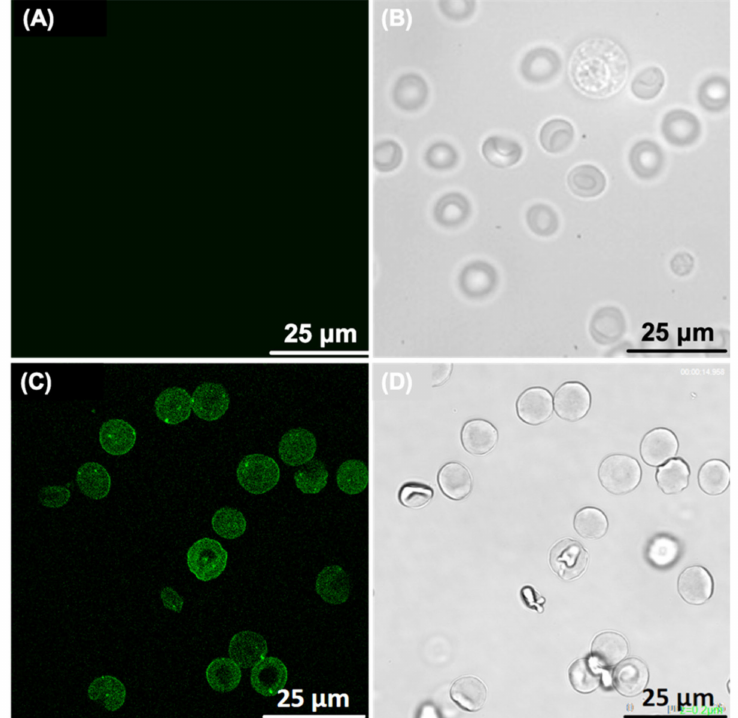
Figure 6. ( A , B ) confocal microscopy images of control RBCs—without liposomal formulation (fluorescence—( A ) and transmission ( B )—mode). ( C , D ) confocal microscopy images of the RBCs in- fluenced by P1 liposomal formulation of Photolon (fluorescence—( C ) and transmission ( D